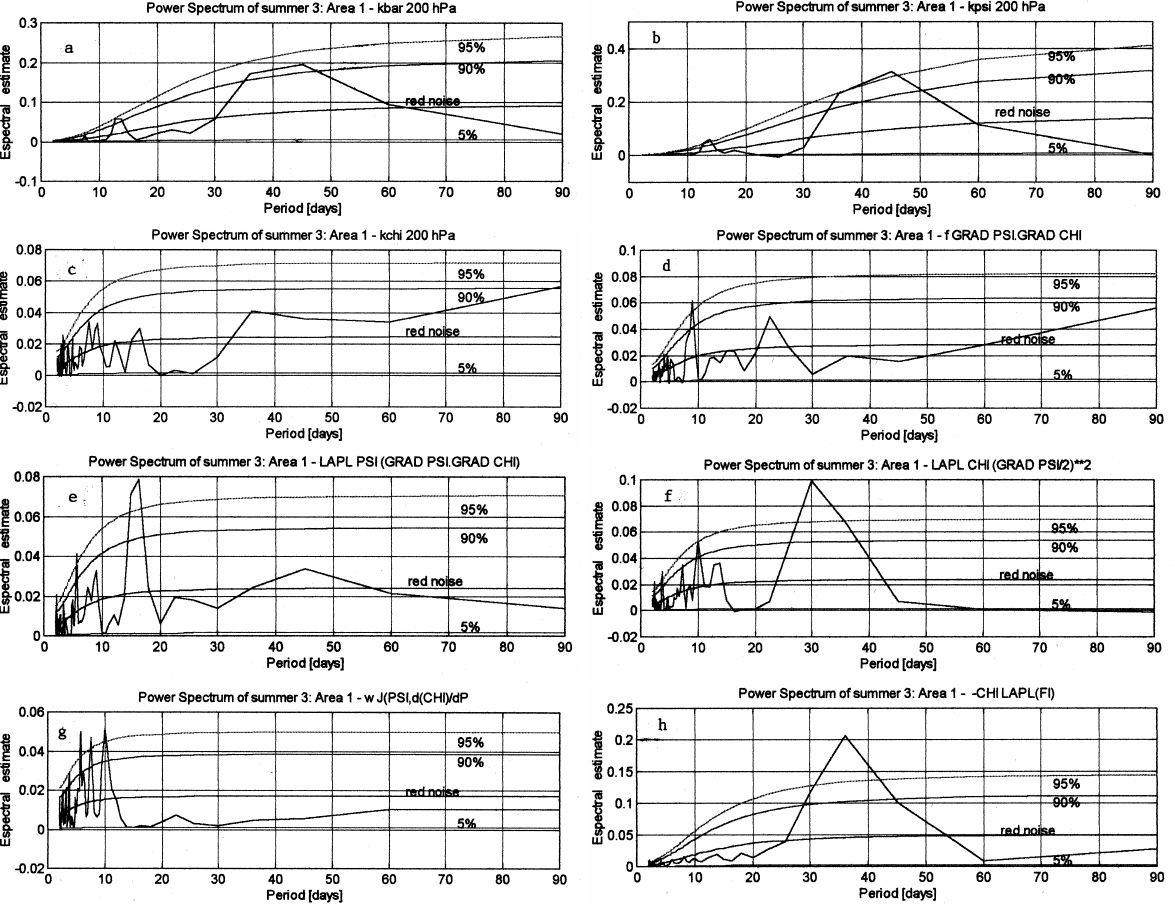
Fig. 4. Power spectrum estimated by method of Mitchell et al. (1966) in summer 3 in the area 1 for the terms: (a) K at 200 hPa, (b) K ψ at 200 hPa, (c) K χ at 200 hPa, (d) f ∇ ψ · ∇ χ , (e) ∇ 2 ψ ∇ ψ · ∇ χ , (f) 1